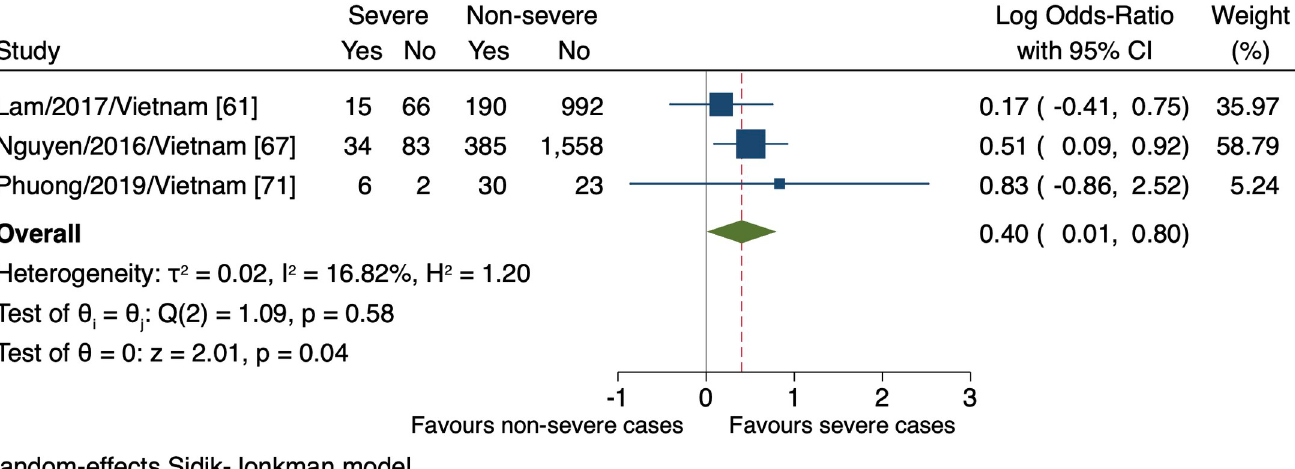
Fig 4. Forest plot showing the relationship between the presence of abdominal pain and severe dengue. The red dashed line represented the overall effect size.